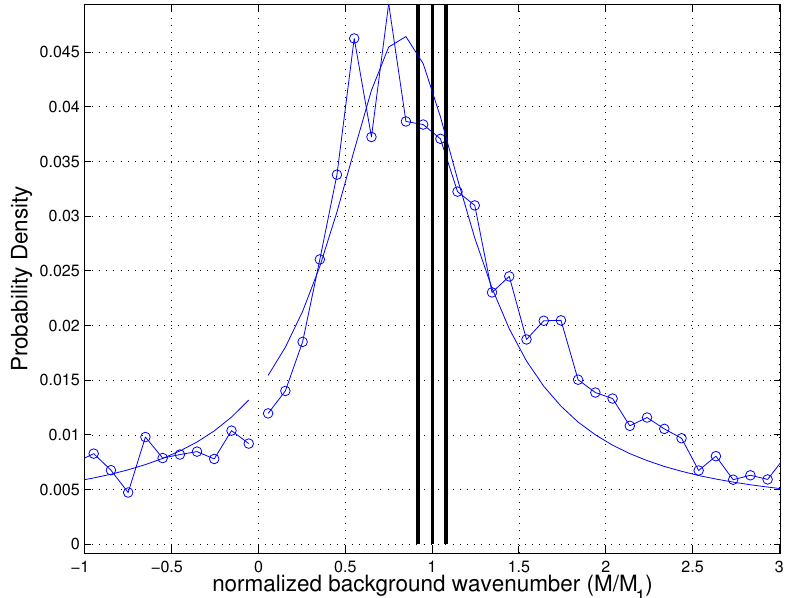
Figure 8. An example of a resonance half-width estimate for e o / e GM = 1 × 10 − 2 . Circles represent (26). The background wavenumber is normalized by the nominal resonant